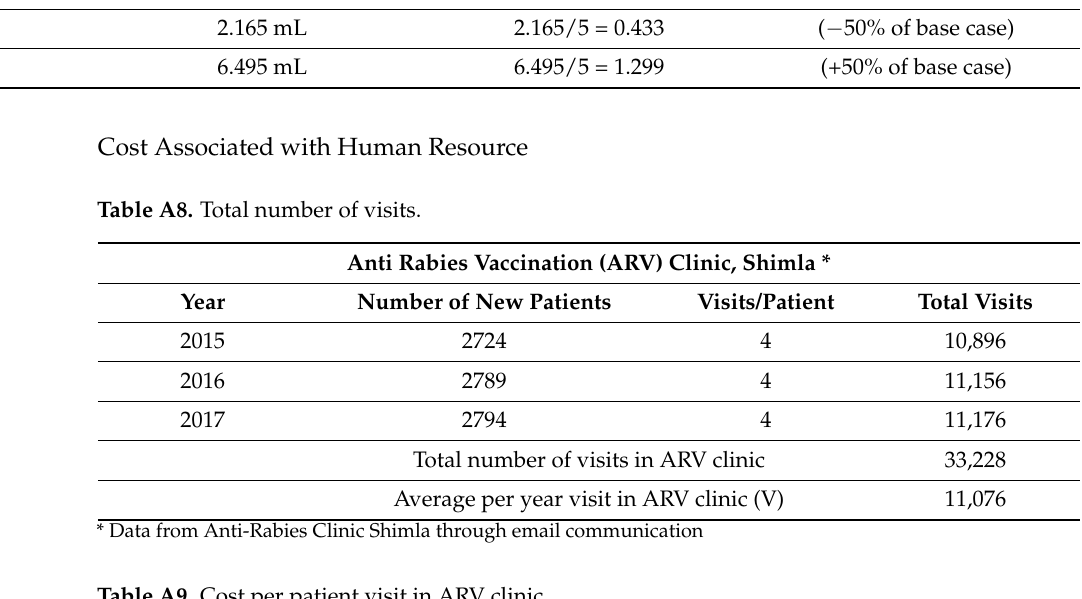
Table A9. Cost per patient visit in ARV clinic.